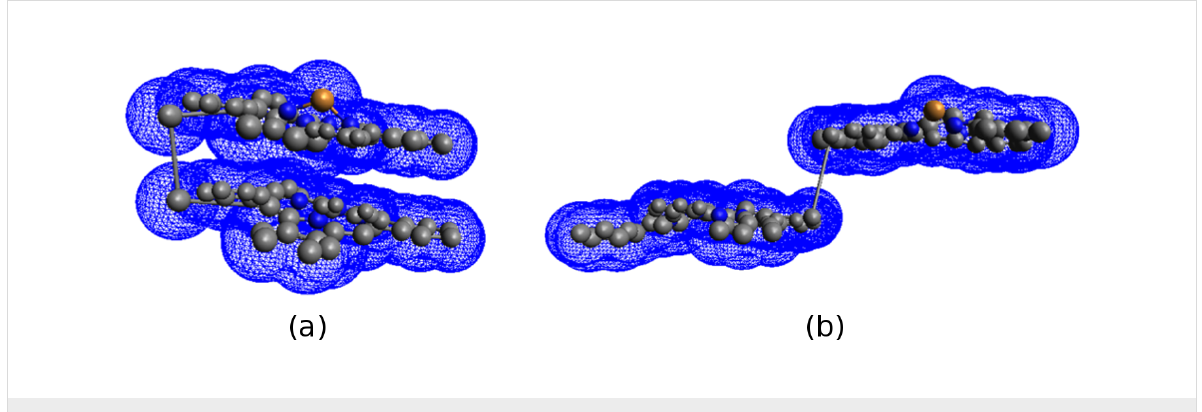
Figure 1: (a) Syn - and (b) anti -conformations of an ethano-bridged bis-porphyrin.